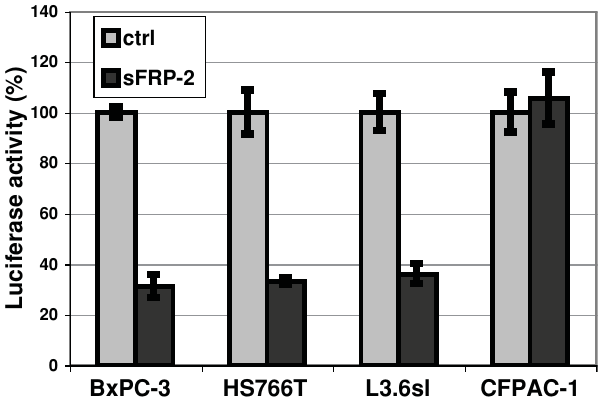
Figure 2. Autocrine Wnt signaling in pancreatic adenocarcinoma cell lines. The indicated pancreatic adenocarcinoma cell lines were transfected with sFRP-2 cDNA (sFRP-2) or control vector (ctrl) and the TOP/FOPflash reporter system. Wnt activity was determined by luciferase activity. The values shown are the means 6 SD’s for 3 independent determinations. Differences between sFRP and control were significant in the Student t-test with p values of , 0.002 for BxPC-3, HS766T and